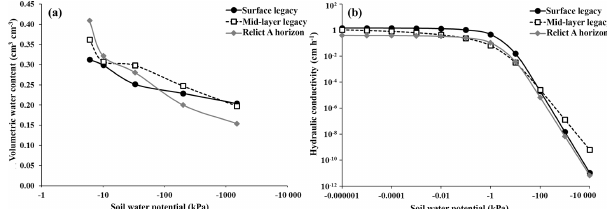
(Table 2) (i.e., at a soil water potential of 0 kPa) was the